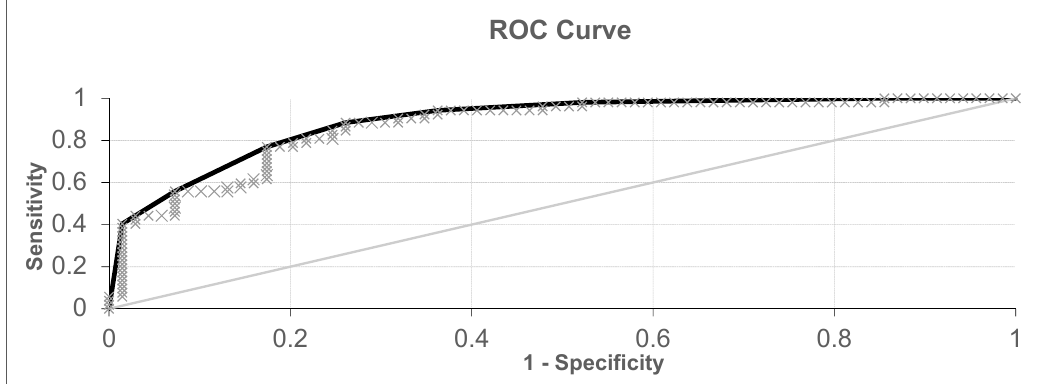
Figure 3. ROC (receiver operating characteristic) curve for all healthy patients, patients with lung cancer, and patients with laryngeal or oropharyngeal cancer (black curve—ROC curve, grey line—Reference line and grey x—experimental points).